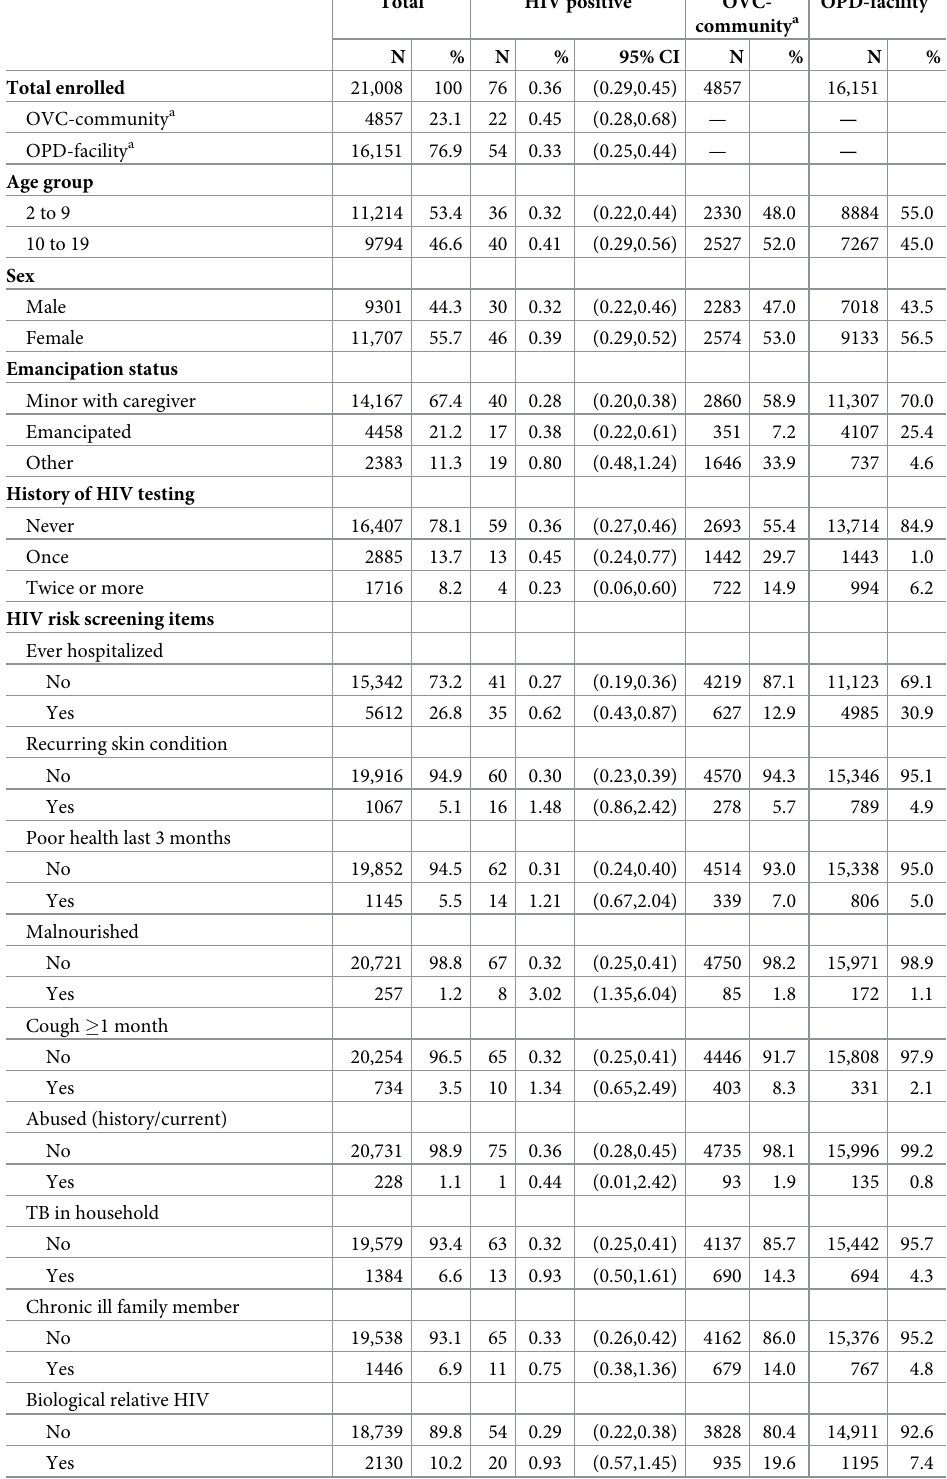
Table 1. Demographic and risk characteristics of study participants by HIV status and sample